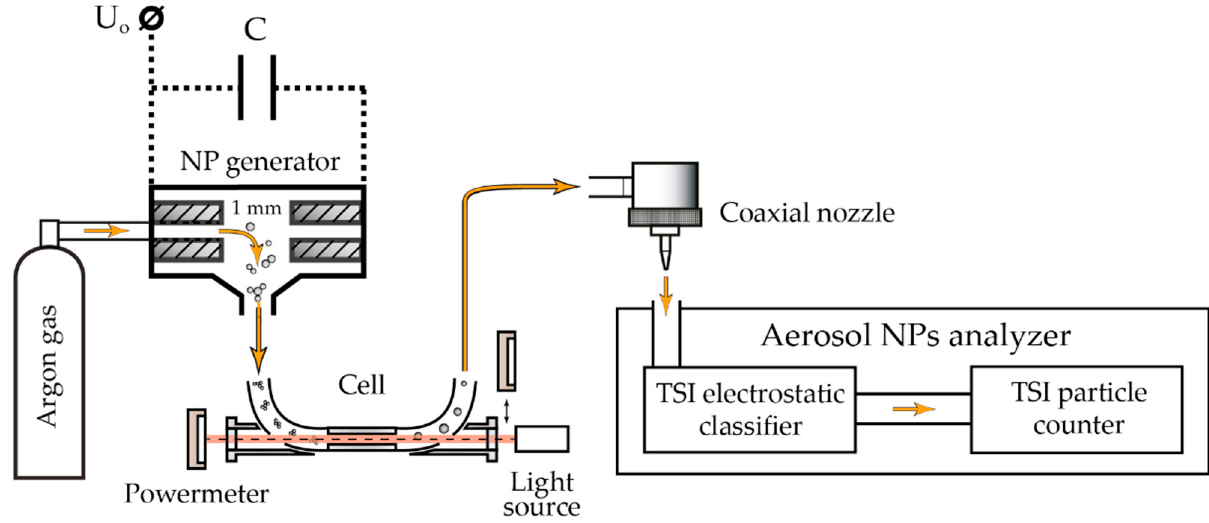
Figure 1. The scheme of the experimental setup.